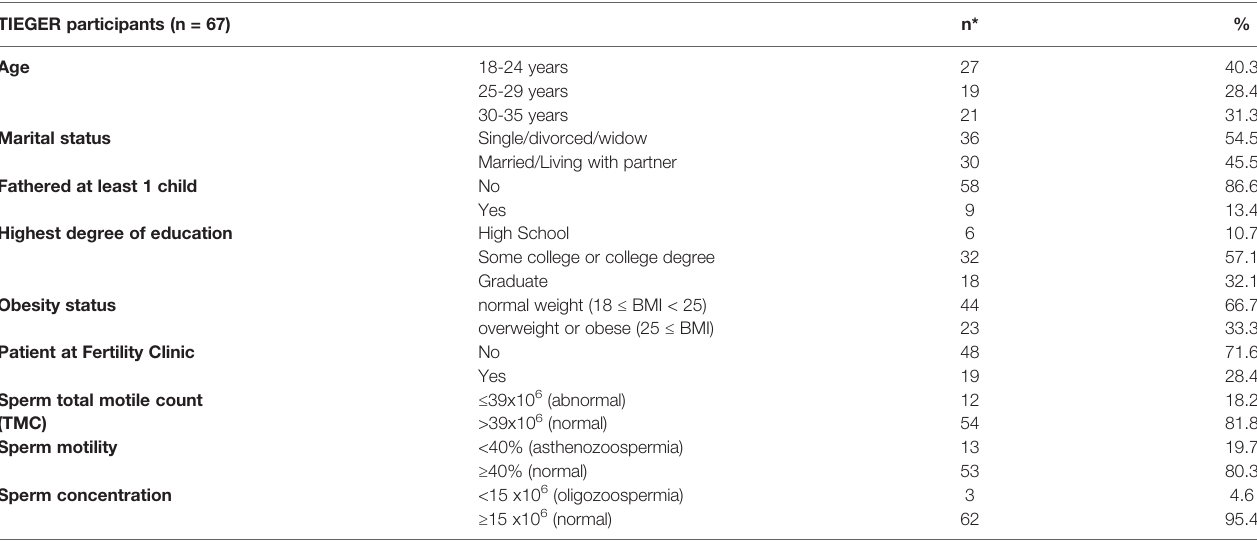
TABLE 1 | Socio-demographics and clinical sperm data of TIEGER study participants. TIEGER participants (n =